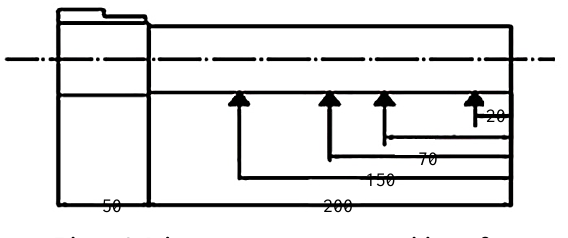
Figure 3. Diameter measurement positions after longitudinal turning of the workpiece [23].